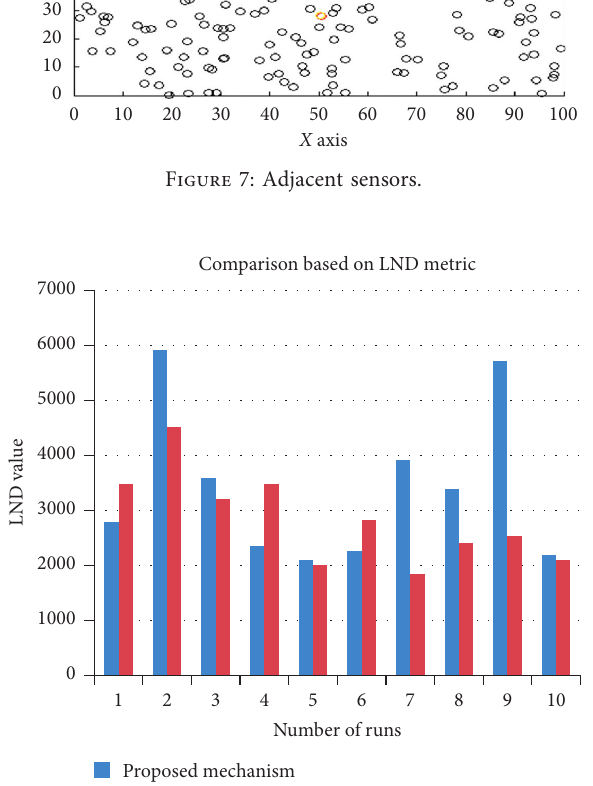
Figure 8: Comparison between the two mechanisms based on